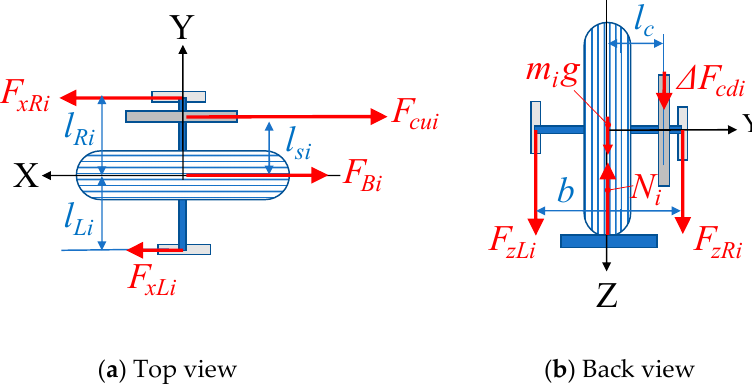
Figure 15. Circumference of the measurement tire.